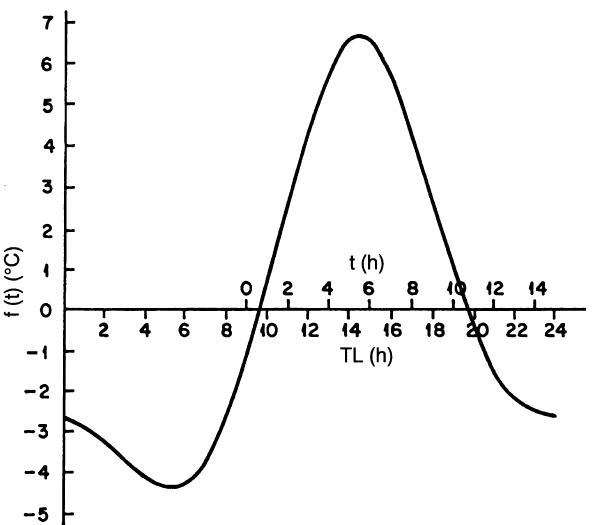
Fig. 5. Diurnal change of land surface temperature f (cid:133) t (cid:134) . The value t (cid:136) 0 corresponds to 9:00 LT. Units are